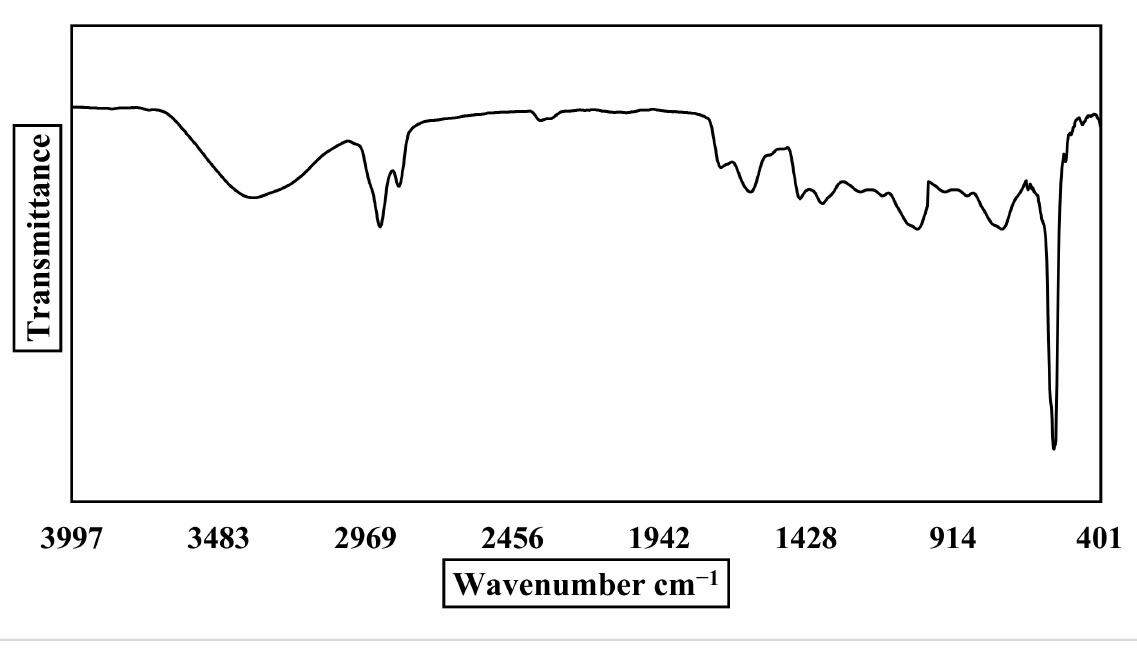
Figure 4. FTIR spectrum of ZnO